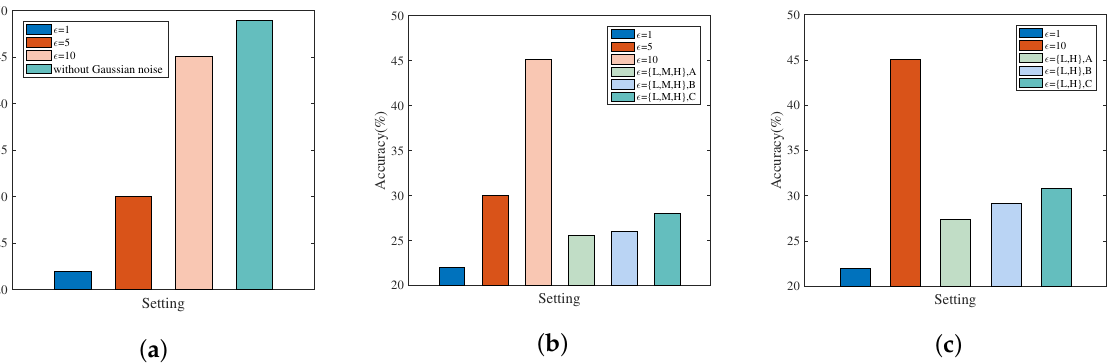
Figure 4. Simulation results on forest cover-types data. Clients’ training data are independent and identically distributed. ( a ) The non-personalized scenario. ( b ) The personalized scenario under the first privacy setting. ( c ) The personalized scenario under the second privacy set- ting. We nominate { 1,1,1,5,5,5,5,10,10,10 } as { L , M , H } (i.e., low, middle, high), and